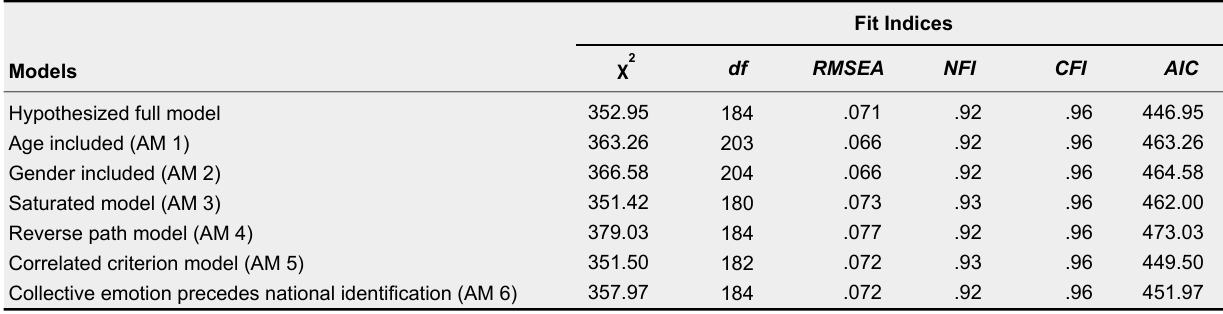
Comparison of Fit Indices of the Hypothesized Full Model and the Various Alternative Models